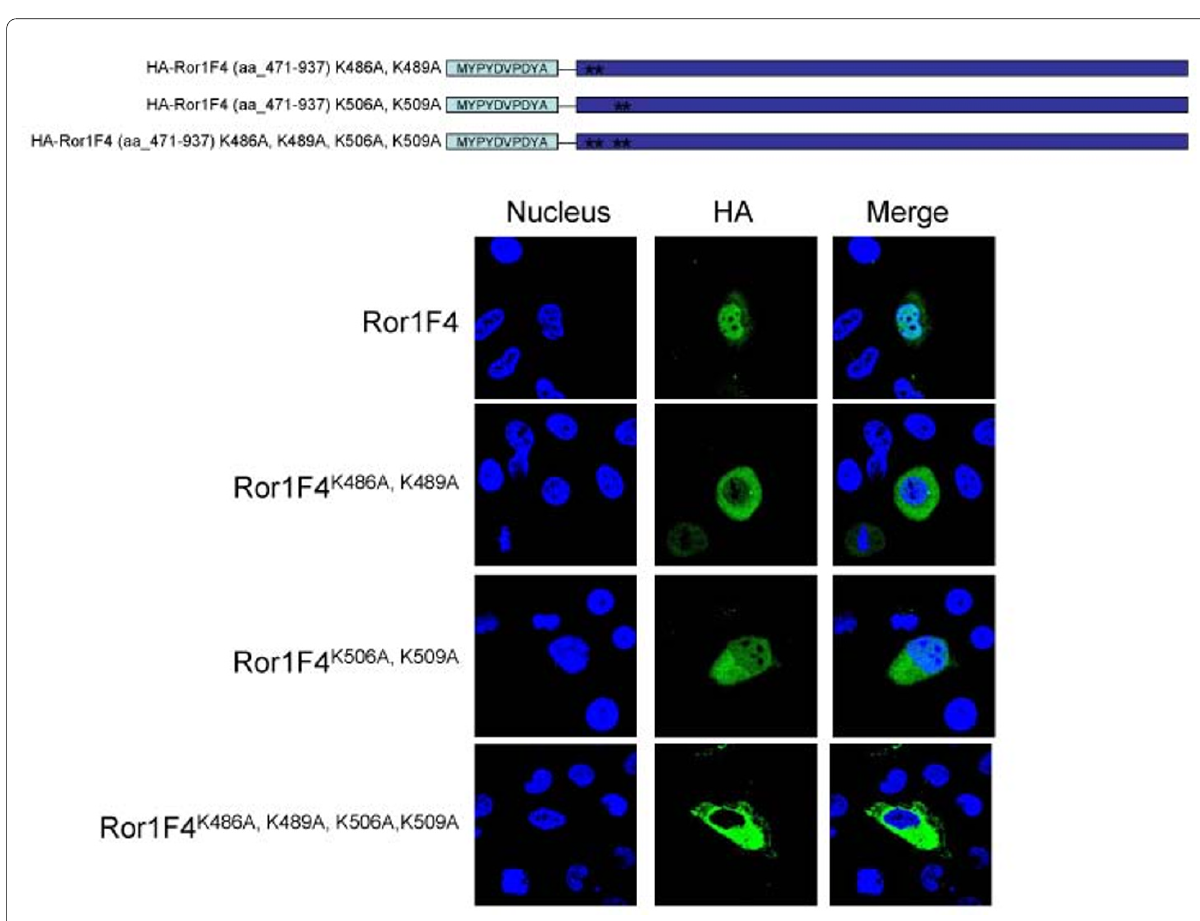
Figure 4 Site-directed mutagenesis on Ror1 NLdomain unveils one nuclear localization signal . HR cells were transfected with indicated Ror1 mutants and analyzed using anti-HA monoclonal antibody (green) followed by a fluorescent (FITC) secondary antibody. DAPI staining shows the nu-